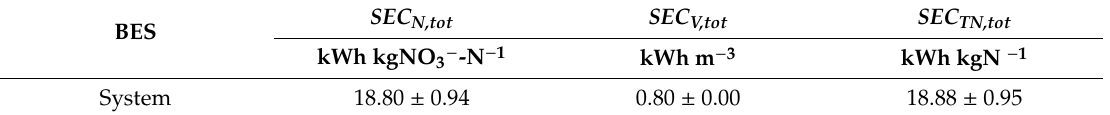
Table 3. Specific energy consumption for the sequential system.